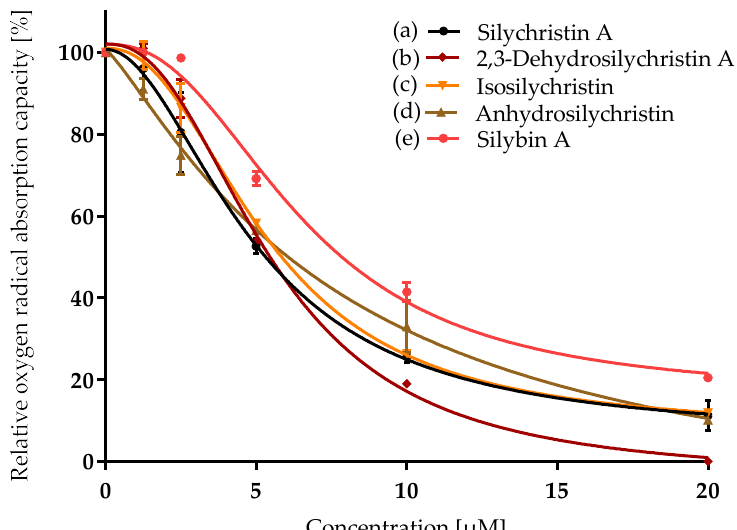
Figure 2. Relative oxygen radical absorption capacity (ORAC) of silychristin derivatives: ( a ) silychristin A; ( b ) 2,3-dehydrosilychristin A; ( c ) isosilychristin; ( d ) anhydrosilychristin; ( e ) silybin A. Data are presented as the average of two measurements with the respective standard error of the mean. The Ymax /Ymin values were as follows: ( a ) 100/11 ± 2; ( b ) 101 ± 1/0; ( c ) 100/12 ± 0.1; ( d ) 100/10 ± 0.1; ( e ) 100/20 ± 0.8.